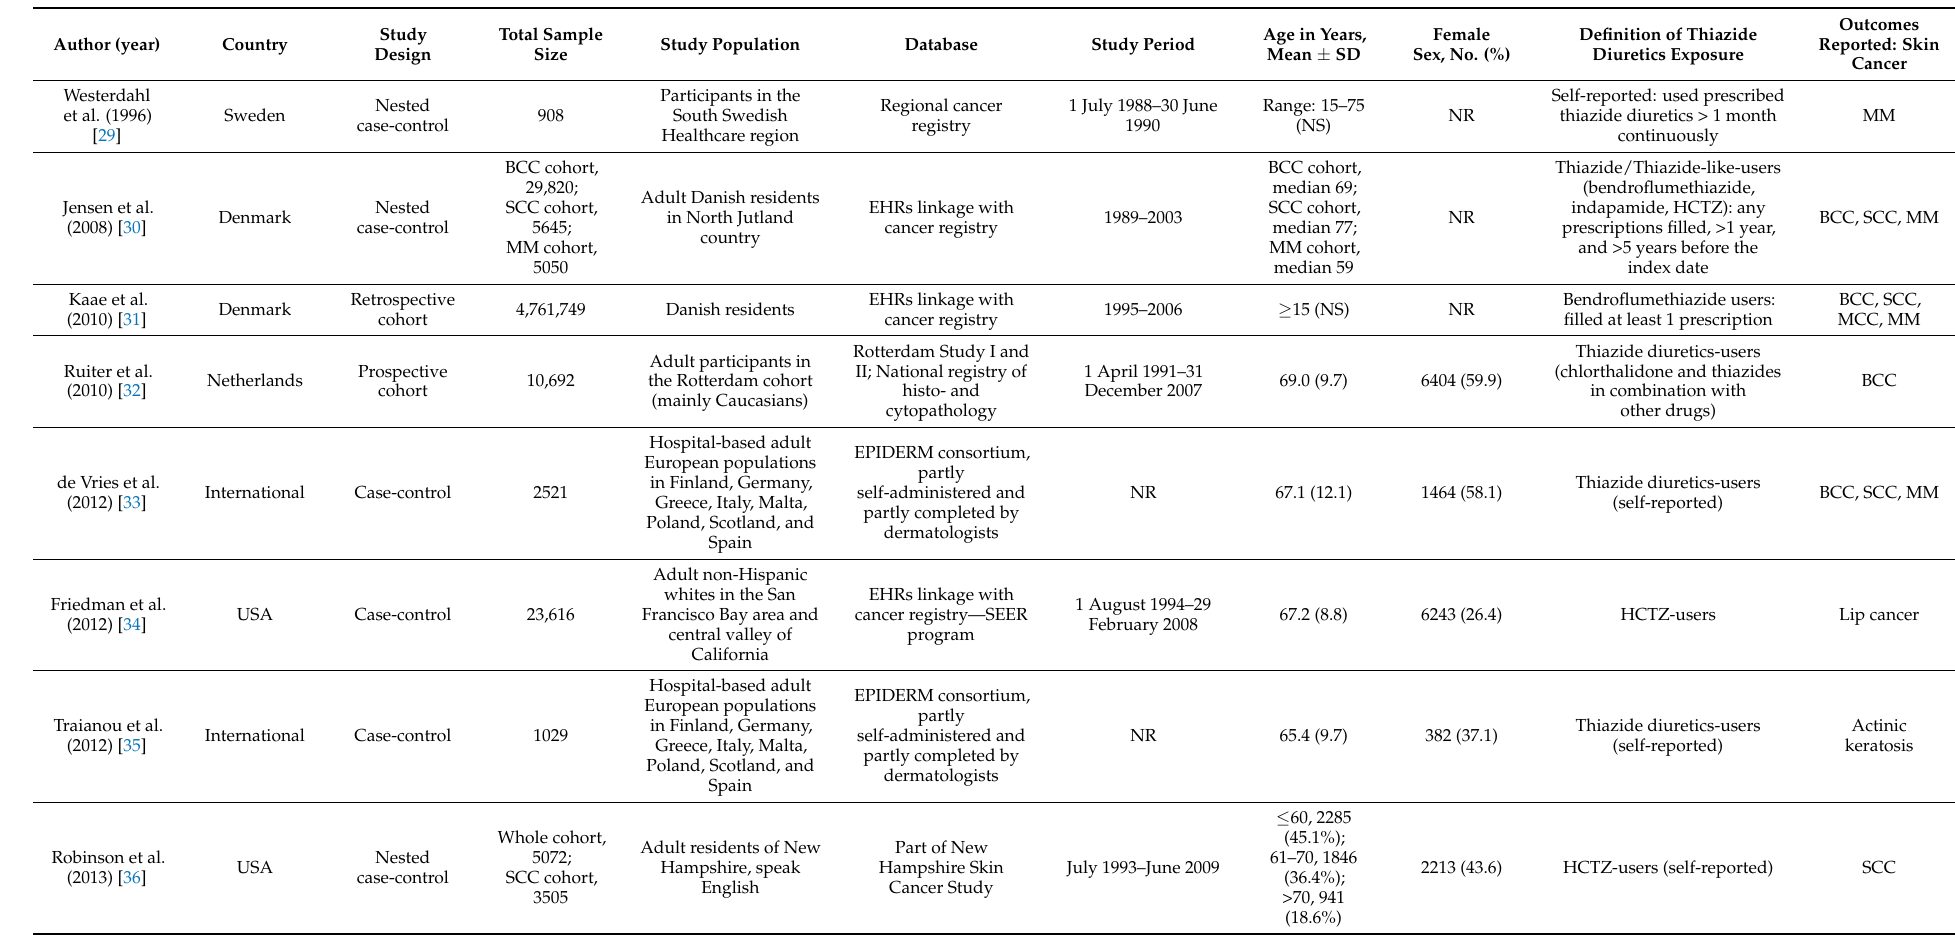
Table 1. Characteristics of the included studies in the